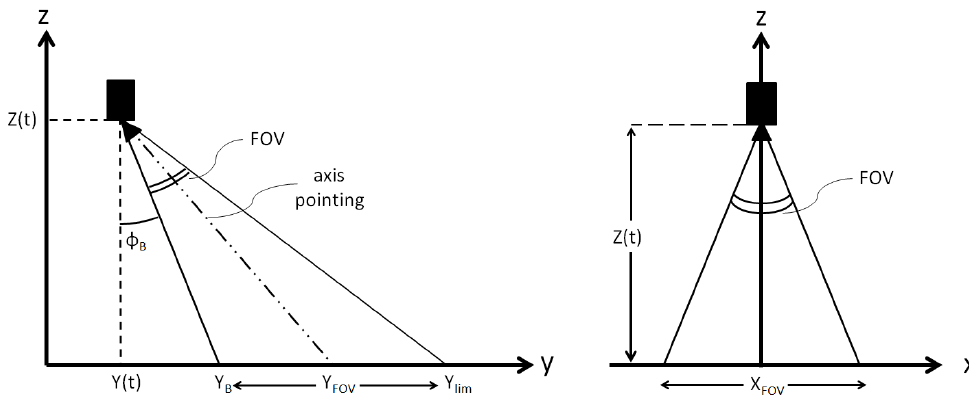
Figure 2. Geometry associated with the